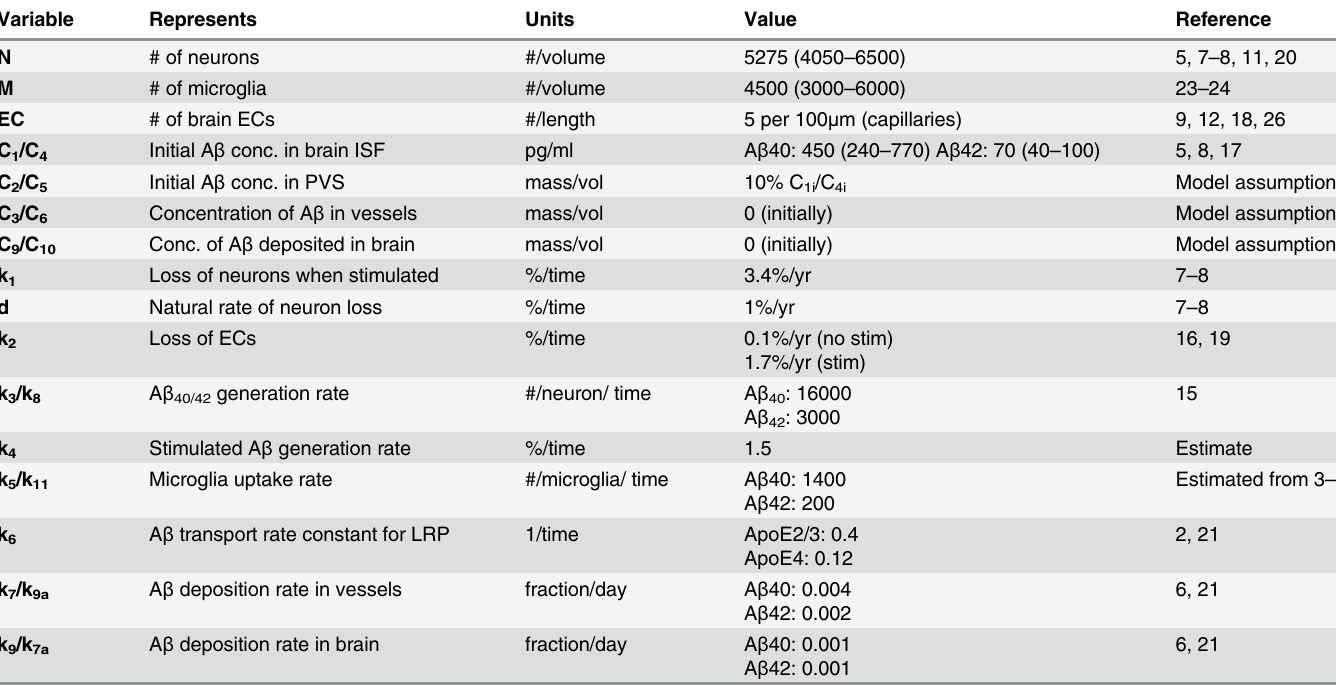
The values for each of the rate constants are given in Table 2. Simulation conditions. The model was simulated using Matlab. Initial conditions assumed that the model described a 30 year old and was run for a total of 50 years. The time- step used was a single day. Thus, a total of 18,250 data points were determined. Sensitivity anal- ysis was completed for rate constants that were estimated (initial concentration in perivascular space, increased generation of A β when a stimulus is present). Table 2. Rate constants and initial conditions used in